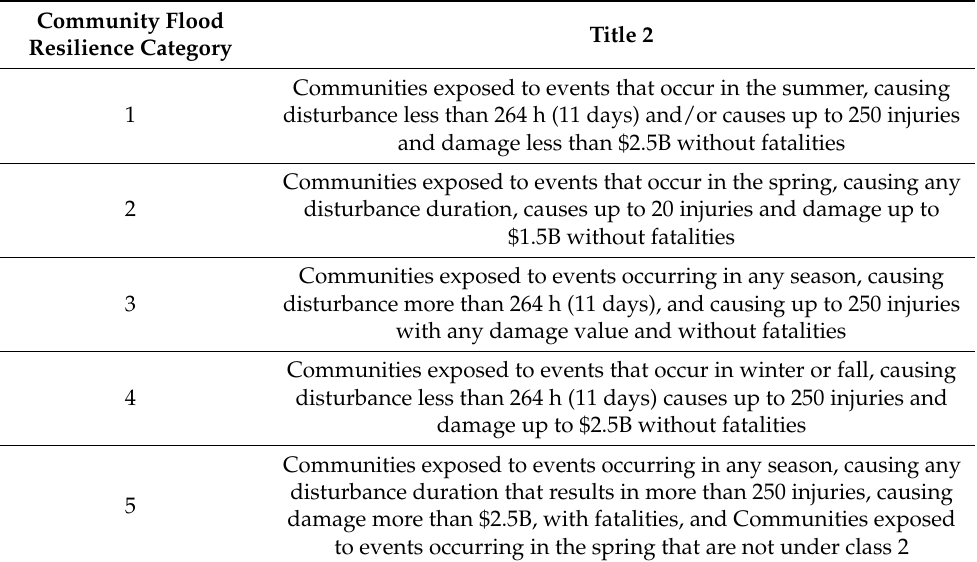
Table 1. The community flood resilience-based categories.